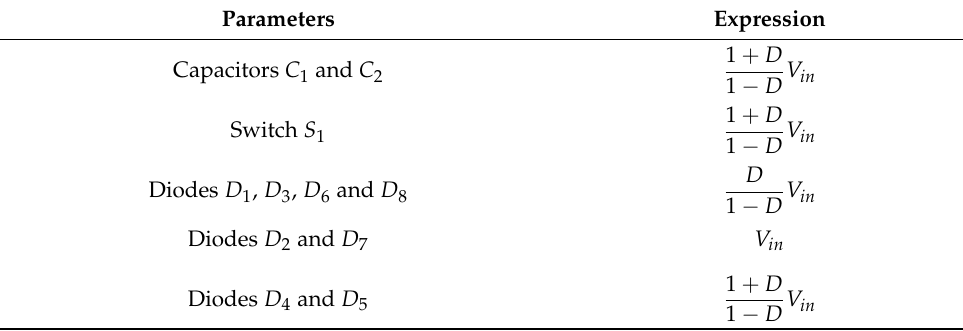
Table 3. Equations of voltages for type-3 SLSC CUK converter.